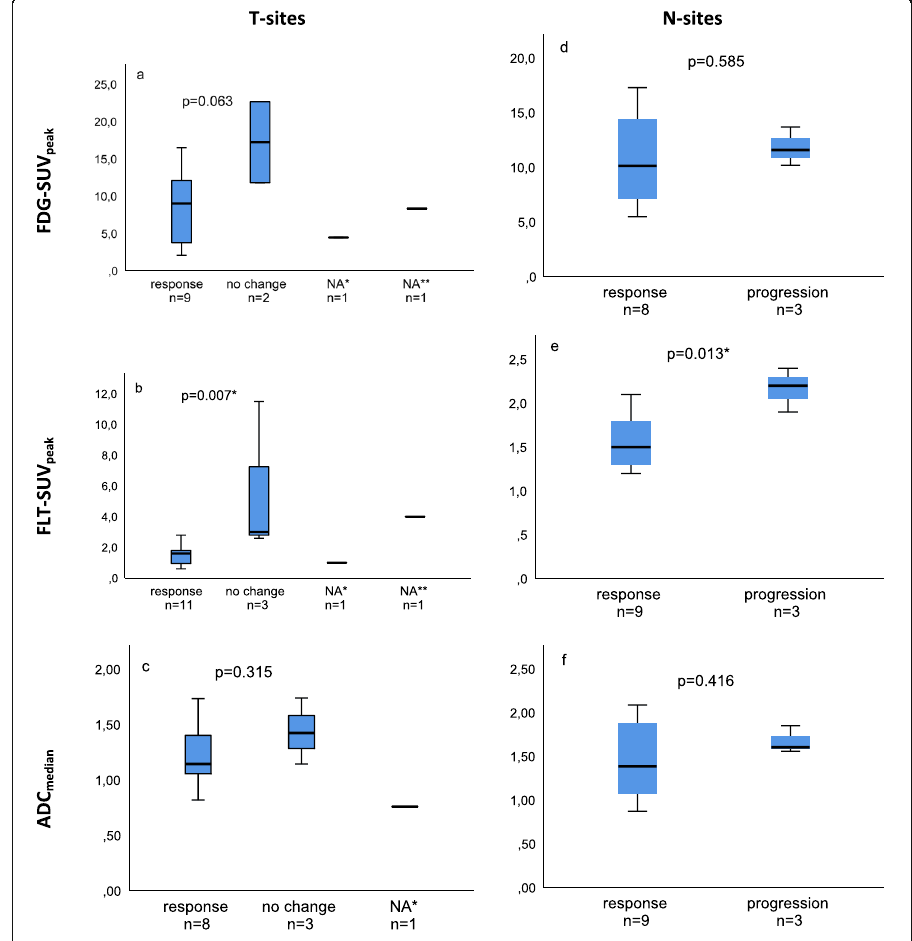
Fig. 6 FDG-SUV peak , FLT-SUV peak , and ADC median in lesions with response vs. lesions with no change or progression. T-sites are shown in left panel ( a – c ) and N-sites in right panel ( d – f ). Note that no T-sites progressed during chemotherapy, and no N-sites had no change. FLT-SUV peak was significantly different in T-sites with response vs. no change ( b ) and in N-sites with response vs. progression ( e ). Three lesions with response had no signal on DW-MRI and are not included ( c ). Lesions that were not evaluated for response are included for completeness. NA*: response evaluation was not available due to atelectasis. NA**: